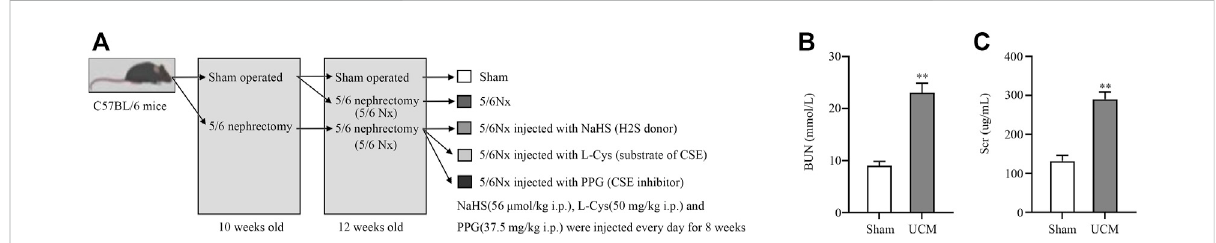
FIGURE 1 Invivo protocol andindex ofrenal function intheShamand uremic cardiomyopathy (UCM) groups. (A) Animal grouping and timelinefor in